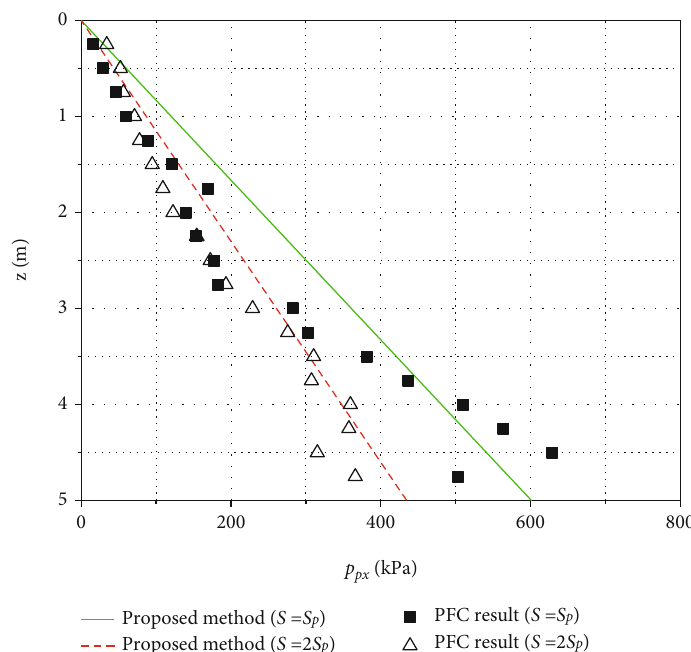
Figure 12: Comparison of the distribution of passive earth pressures along depth between the theoretical solution and PFC results.